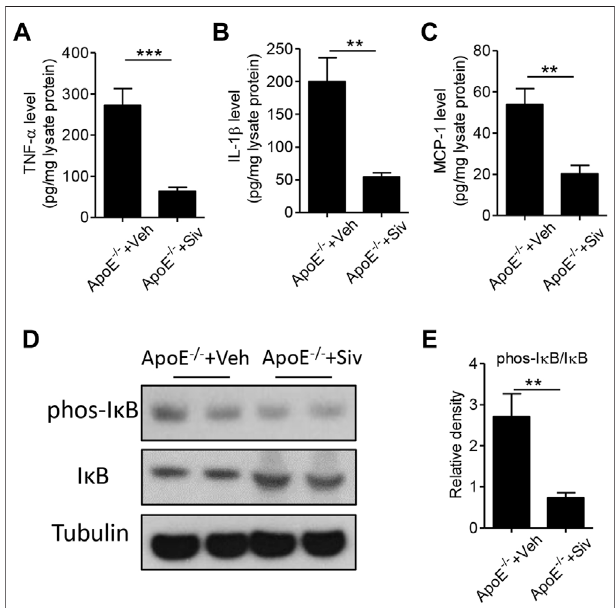
FIGURE 4 | Sivelestat attenuates intestinal in fl ammation in HFHC-fed Apo E -/- mice and NE-treated intestinal epithelial cells. (A – E) Male Apo E -/- micewerefedwithHFHCdietfor4 weeksandthentreatedwithsivelestat(Siv, 50 mg/kg per day, intraperitoneal injection) or Veh for 8 weeks. ELISA analysis of intestinal protein levels of TNF- α (A) , IL-1 β (B) , and MCP-1 (C) . Immunoblotanalysisofproteinexpressionsofphosphorylated(phos-)I κ Band I κ B (D) and quantitative analysis of the relative density of phos-I κ B/I κ B (E) . Data are shown as mean ± SEM. n = 6 mice/group, and ** p < 0.01 and *** p <